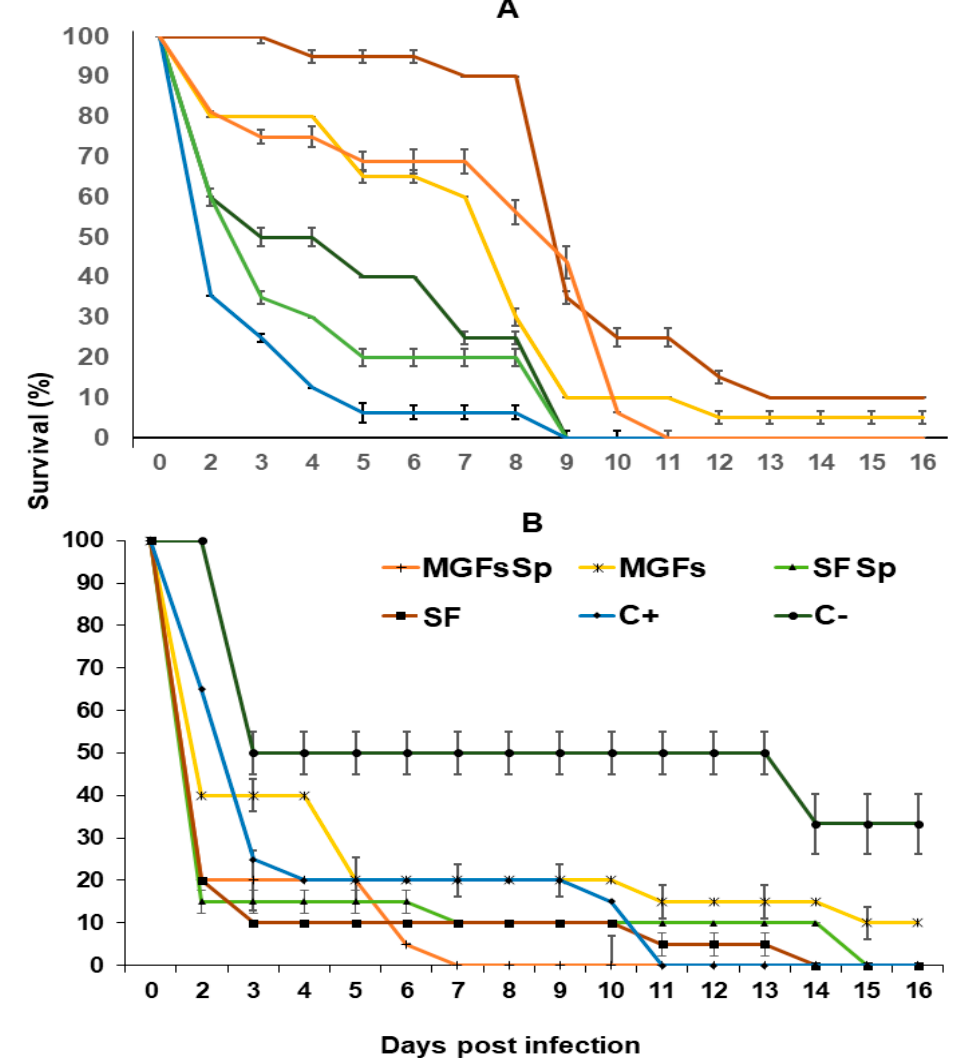
Figure 5. Survival percentage of Aedes aegypti adults exposed to four different formulations of the B. bassiana BBPTG4 strain stored for ( A ) zero days and ( B ) 30 d. The four different formulations stored at 4 °C and 25 °C. Data represent mean + SEM of triplicate determinations from three independent experiments. MGF + Sp = microgranular formulation + Spirulina , MGFs = plus sugar, SF = solid formulation, C+ = positive control, C- = negative control.